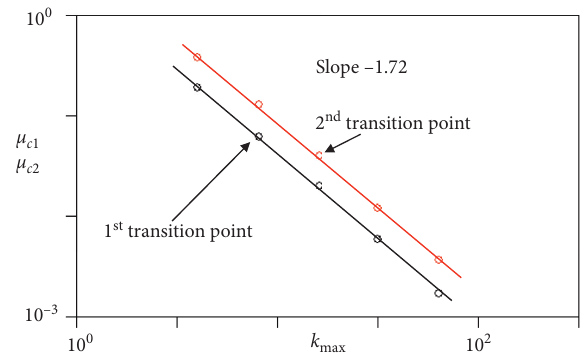
Figure 4: Log-log plot of first and second transition points μ against highest degree k . Black and red circles indicate μ c max 2 transition points μ c and μ c , respectively. The transition points are 1 2 on the linear lines. The slope of the first transition point agrees with that of the second transition point. The following scaling is ob- ∝ μ c ∝ k − 1 . 72 tained: μ c 1 2 max